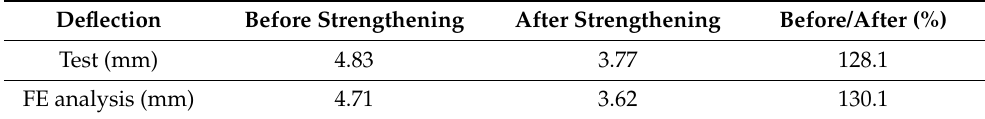
Table 4. Comparison of the deflection of the 1# girder at the mid-span under the symmetrical load.